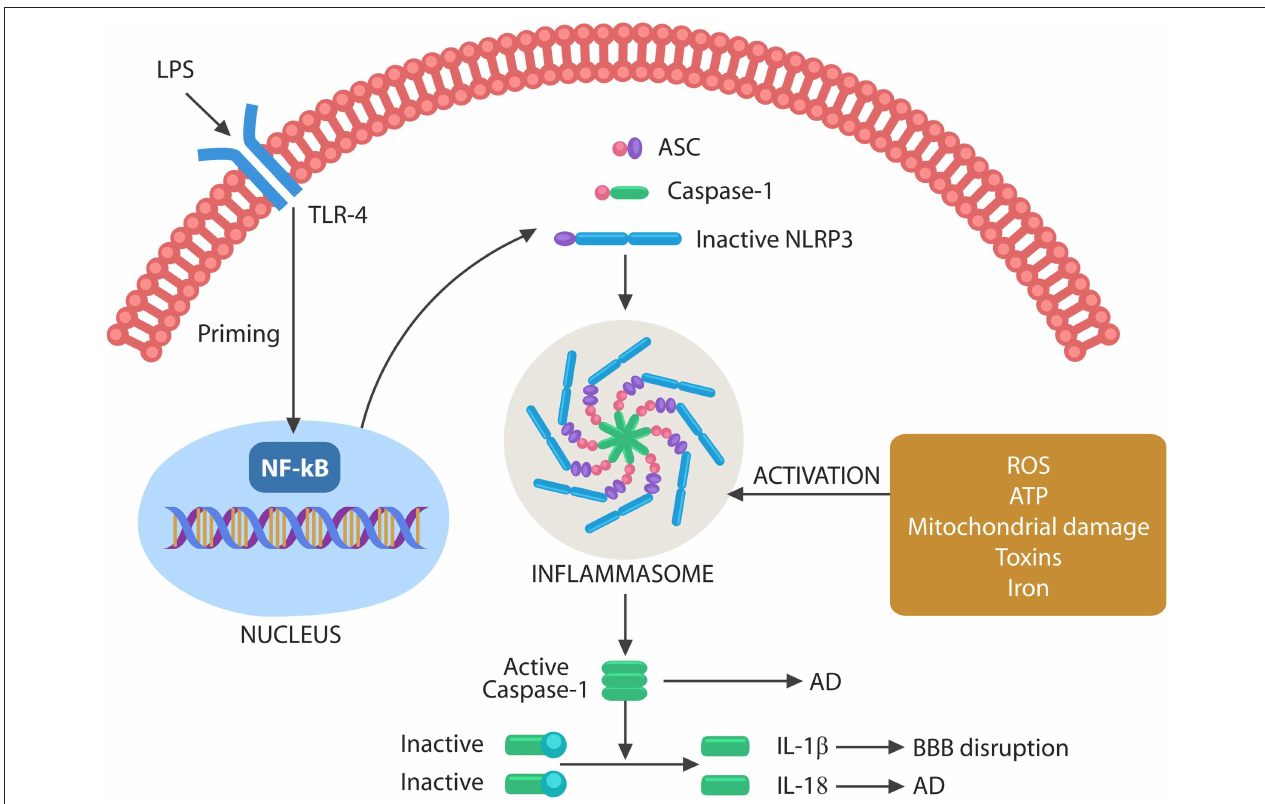
FIGURE 3 | Schematic representation of NLRP3 activation by microbes or their molecules. Microbes or LPS binds to TLR-4, activating the nuclear NF-kB that primes NLRP3. The second step necessary for NLRP3 activation can be composed of various exogenous or endogenous stimuli, including ROS, ATP, DNA,